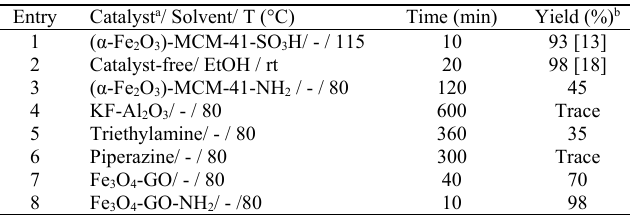
Table 3. Comparison of the efficiency of different catalysts in the synthesis of 5d.